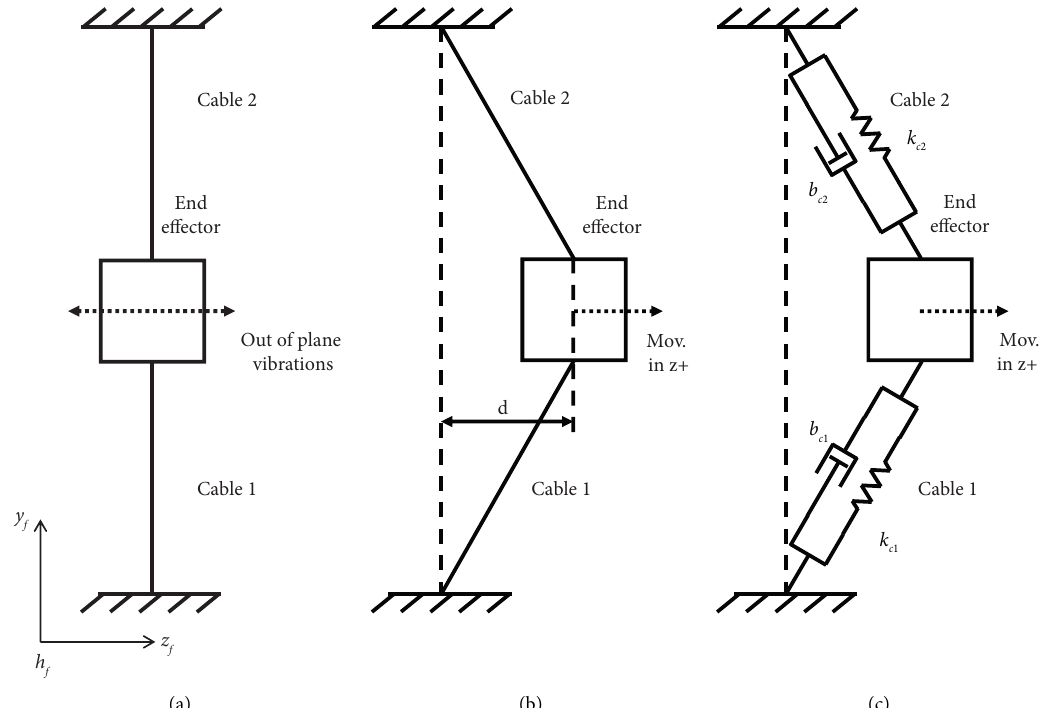
Figure 2: Representation of the out-of-plane vibrations. (a) End efector in its equilibrium position, (b) end efector out of its equilibrium position, and (c) cables with their equivalent viscoelastic model.